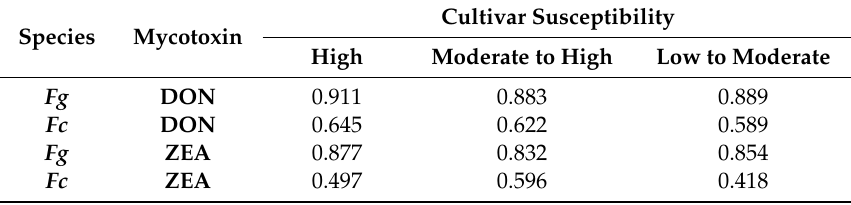
Table 6. Correlation coe ffi cients ( r ) between DNA amounts (pg fungal DNA / ng plant DNA) of F. graminearum ( Fg ) and F. culmorum ( Fc ) and DON and ZEA concentrations ( µ g / kg) in wheat grain of the highly, the moderately to highly and the lowly to moderately susceptible cultivar summarized for the years 2013 to 2017. n = 315. Cultivar Susceptibility Species Mycotoxin High Moderate to